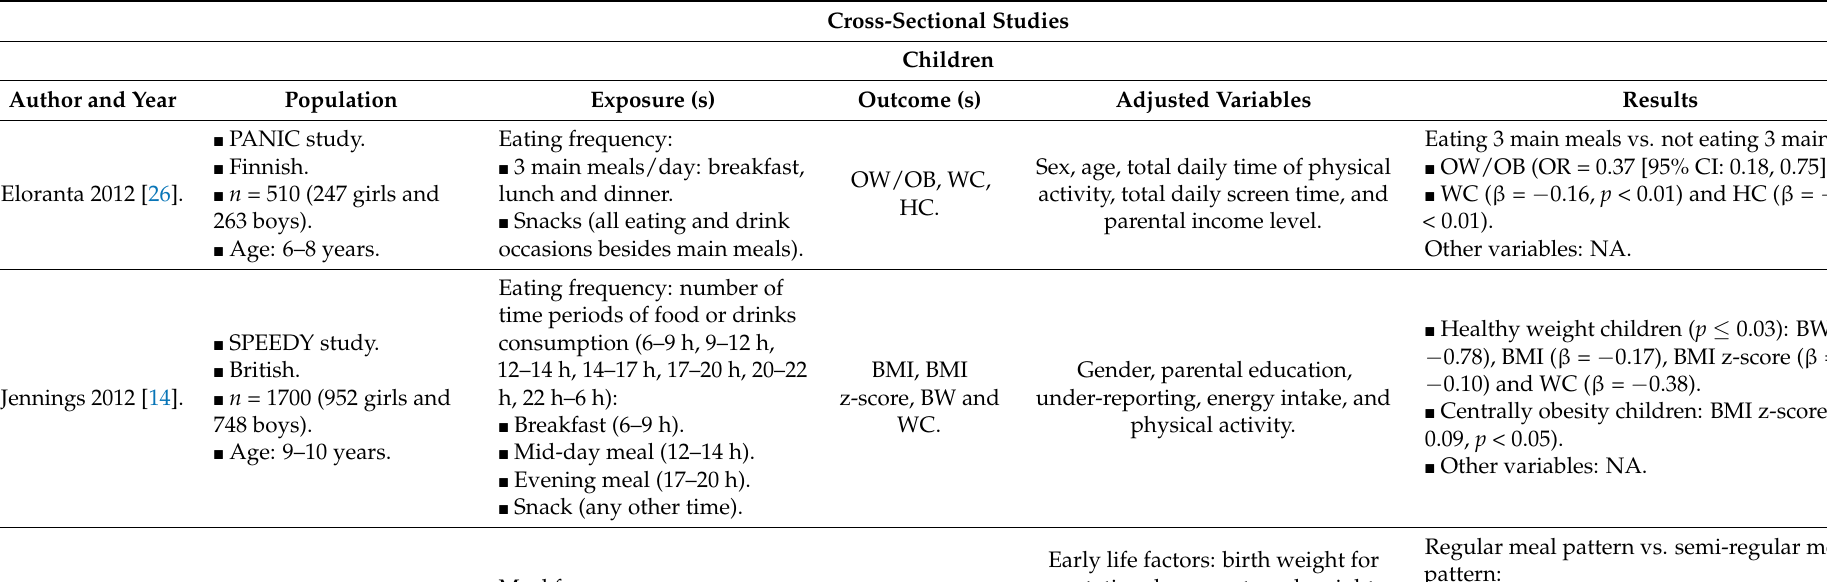
Table 2. Characteristics and main findings of cross-sectional studies that explored eating